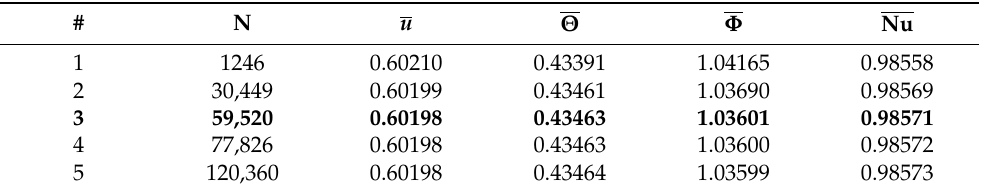
Figure 2. Mesh from coarse to fine: ( left ) 1246 elements, ( center ) 30,449 elements, ( right ) 59,520 elements. Table 1. Grid independence test. N is the mesh elements number, u is the mean velocity, Θ is the mean temperature, Φ is the mean concentration and Nu is the mean Nusselt number. The mesh validation is done for Re = 100, Pr = 6.2, NB = NT = 0.1 and Le =